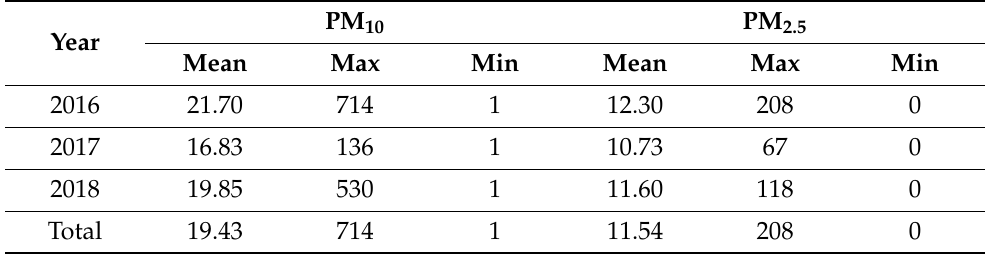
Table 2. Yearly Mean, Max and Min values of PM 10 and PM 2.5 concentrations in the AGP monitoring station for the period 2016–2018.